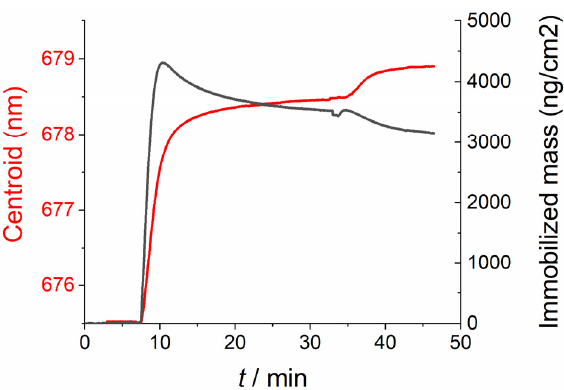
Figure 13. NPS signal and calculated immobilized wet mass (from QCM-D data) obtained from the adhesion, of DSPC:DSPE-PEG2000 (96:4 mol%) liposomes on a silica surface at 21